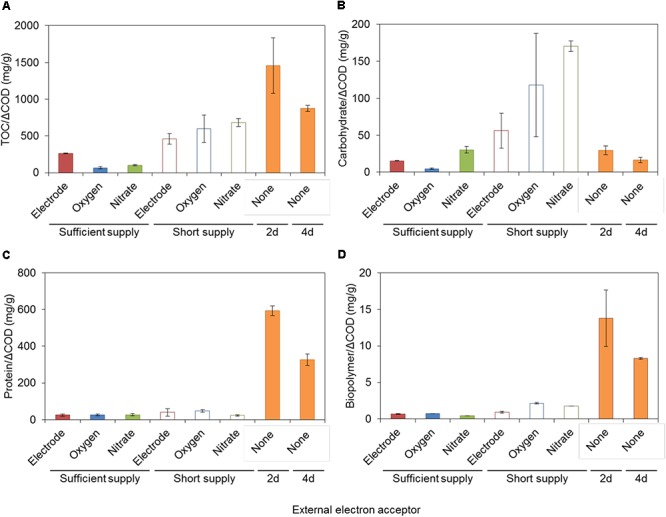
(A) TOC, (B) carbohydrate, (C) protein, and (D) biopolymer in SMP produced by strain S05 with different external electron acceptors. Statistical differences were estimated with P-value on the basis of two-sample t-test, which was summarized in Supplementary Table S2.